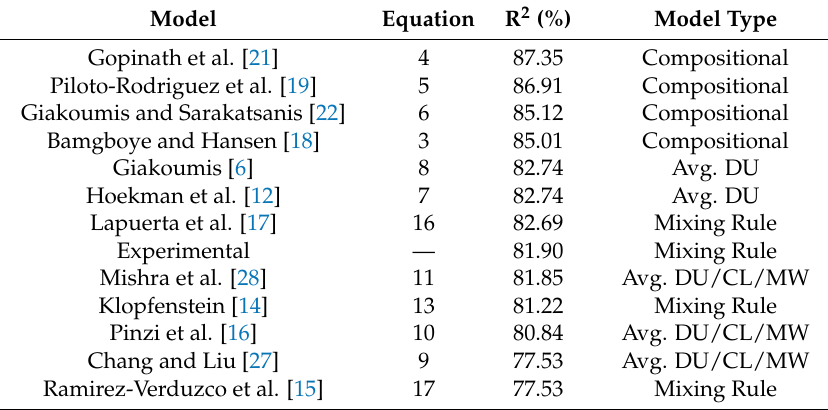
Figure 9. Comparison of predicted (equations from Section 3.3) vs. experimental CN values for the four models based on the neat FAMEs’ cetane numbers and applying the mixing rule for the biodiesel CN (experimental data from the third column of Table 5). Table 7. Coefficients of determination of all models (based on the 50 data lines from Table 5 and Figures 7 ‒ 9).